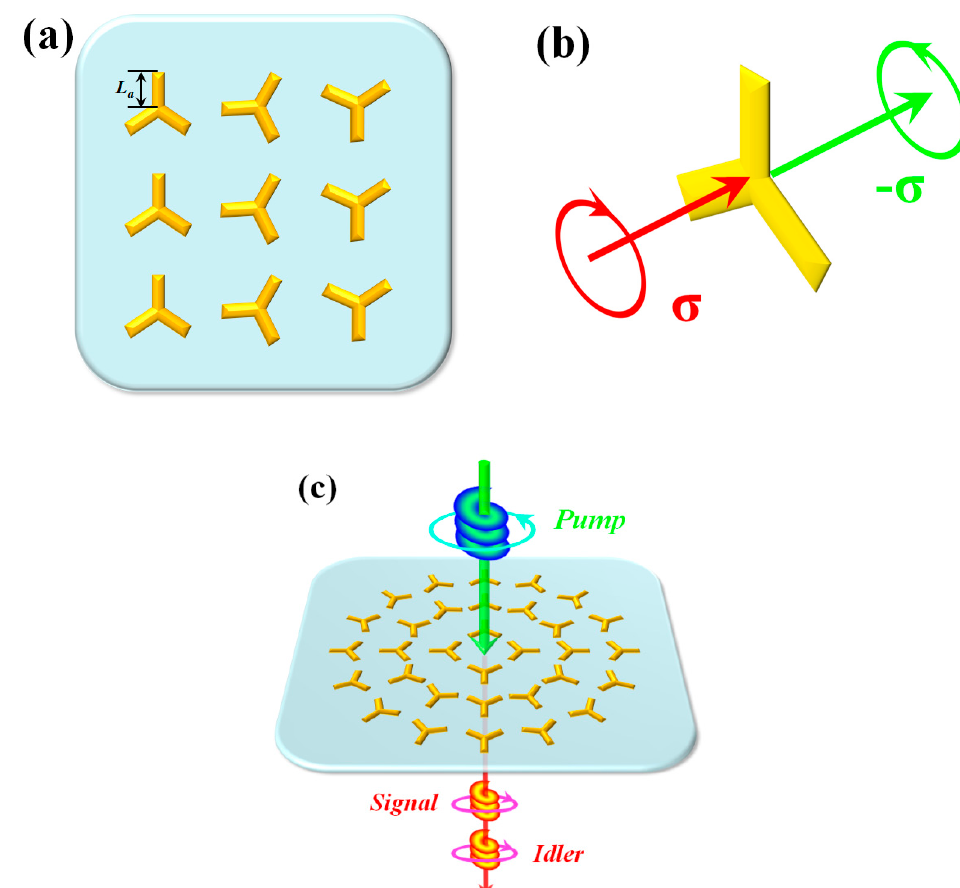
Figure 2. ( a ) The C3 nanoantenna array system. The length of meta-atom arm is marked as L a . ( b ) The quadratic interaction with C3 rotationally symmetrical meta-atom. ( c ) The mechanism of PDC process in the C3 nonlinear metamaterial system.